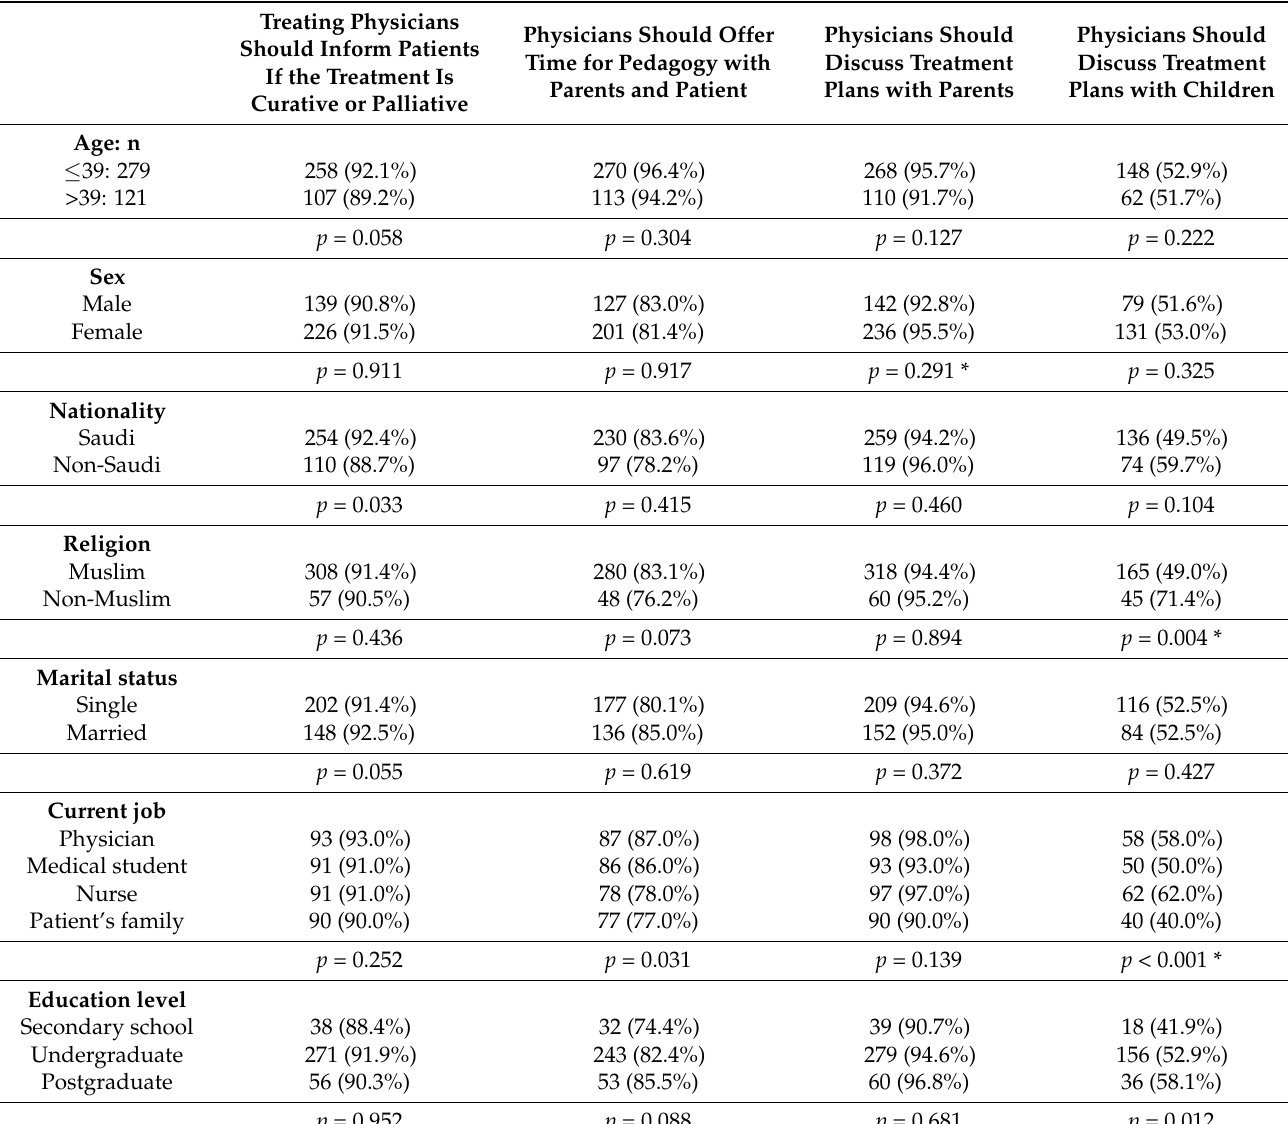
Table 4. Awareness of patients’ rights to